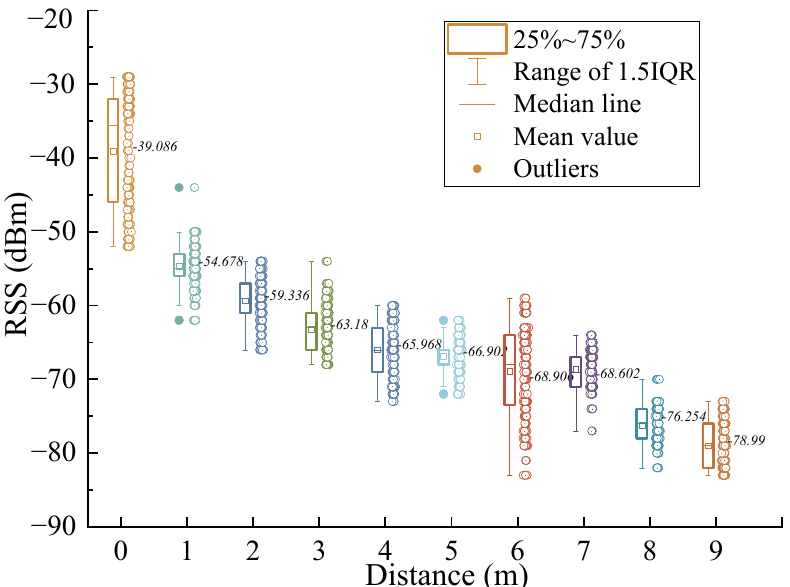
Figure 2. The relationship between distance and